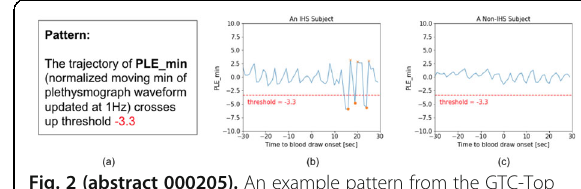
Fig. 2 (abstract 000205). An example pattern from the GTC-Top model which manifests in 7/10 IHS subjects and 0/26 non-IHS subjects, and its manifestation on one example IHS